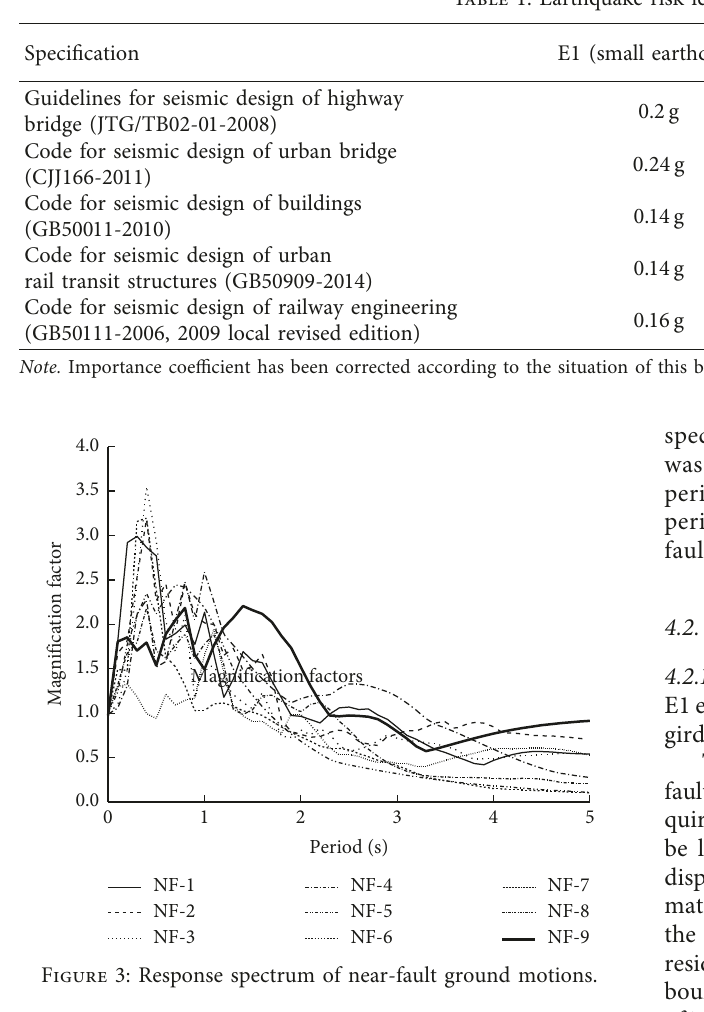
Table 1: Earthquake risk levels for PGA.